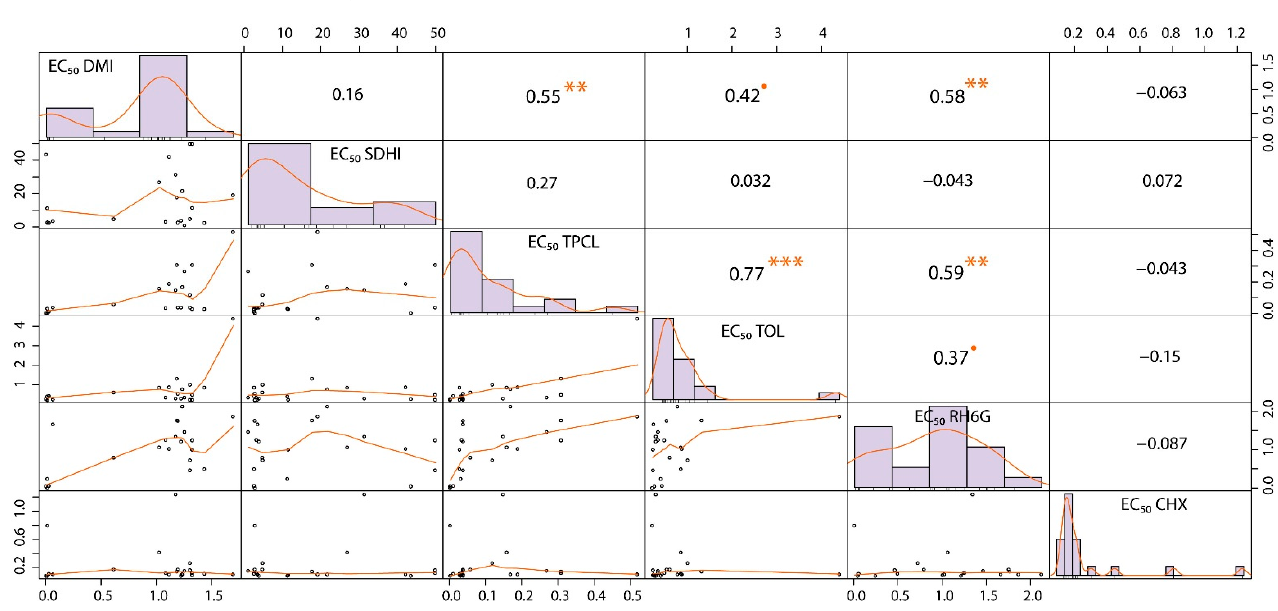
Figure 2. Pearson correlation analysis among the EC 50 values for the efflux pump substrates tolnaftate (TOL), cycloheximide (CHX), rhodamine 6G (RH6G) and triphenyltin chloride (TPCL) and the site-specific fungicides tebuconazole (DMI) and fluxapyroxad (SDHI) determined for Pyricularia oryzae Triticum and Oryza lineages and P. grisea . Diagonal frames represent the distribution of the EC 50 values for each chemical; frames below, the bivariate dispersion and adjusted lines; frames above, the correlations values and the significance levels. Significance of the correlation was determined by t tests. p values were represented by: *** = 0.001; ** = 0.01; o = 0.1.